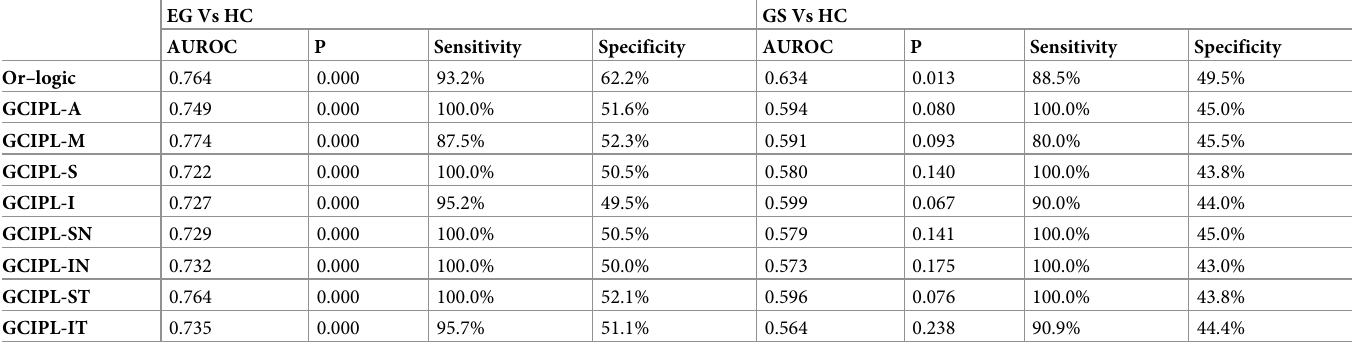
Table 4. Area under receiver operating curve (AUROC), specificity and sensitivity of the GCIPL parameters in diagnosis of early glaucoma (EG) and glaucoma sus- pect (GS). EG Vs HC GS Vs HC AUROC Sensitivity Sensitivity